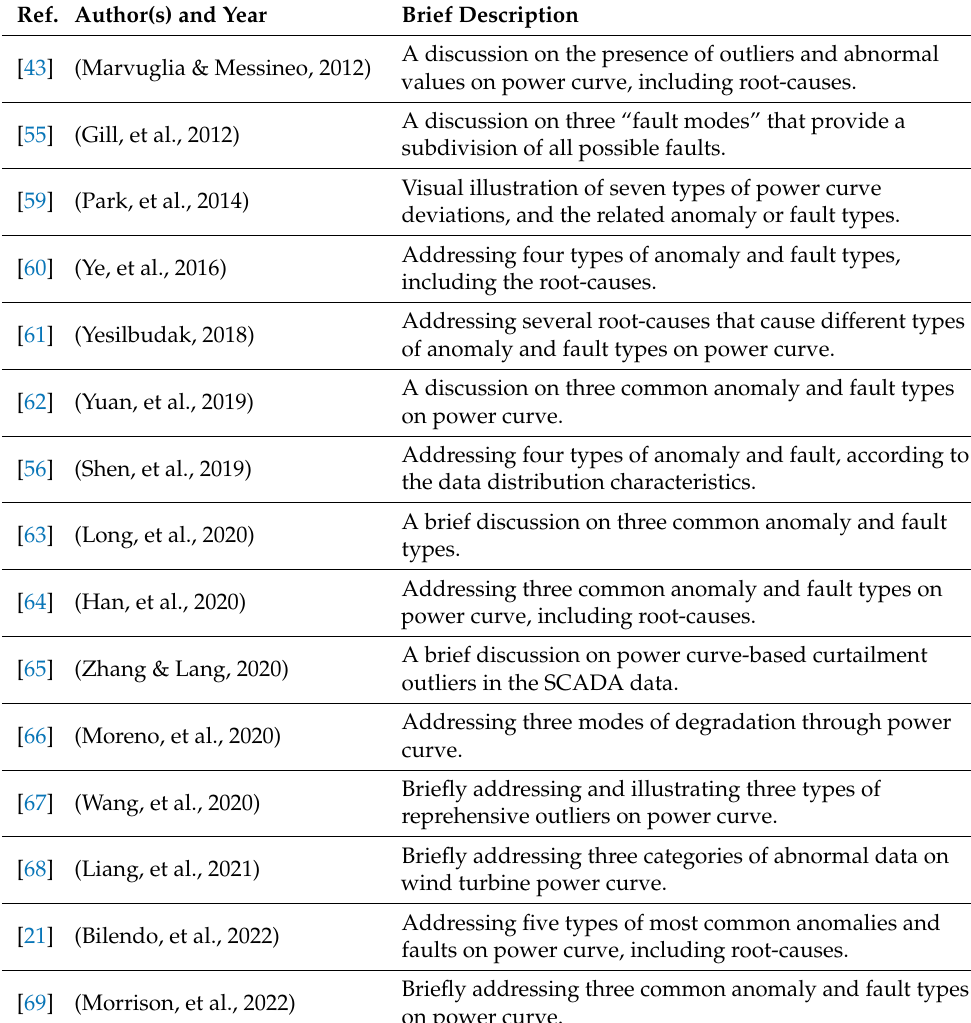
Table 3. Research articles addressing anomalies and